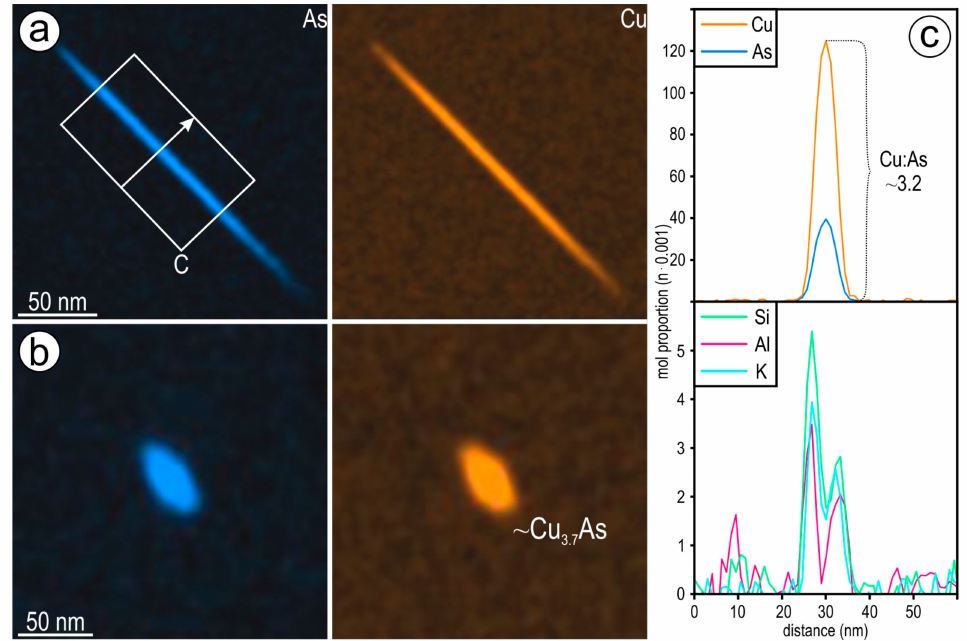
Figure 6. STEM EDX maps of Cu-As NPs hosted within bright bands (foil #1) with acicular (needle in ( a )) and hexagonal ( b ) morphology. ( c ) Integrated, molar-profile across Cu-As-needle shown in ( a ). Note the positive correlation between Si, K and Al (sericite?) on the margins of the Cu-As NP. The profiles correspond to background-subtracted intensities to avoid interference from the copper grid.